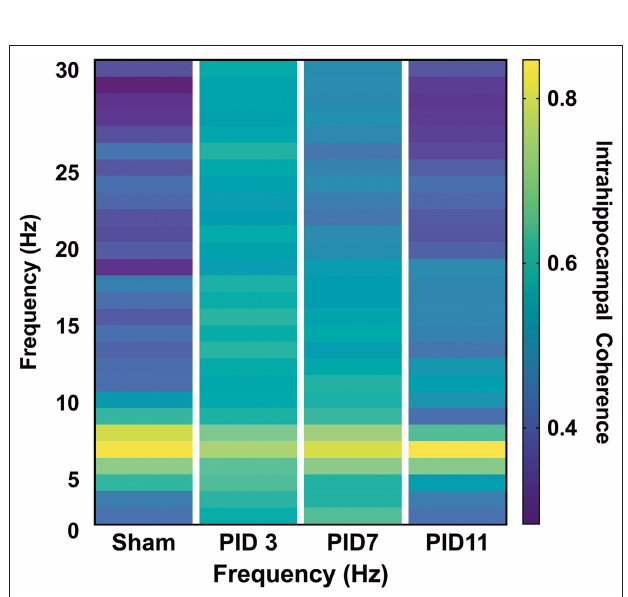
FIGURE 4 | Intrahippocampal Phase Coherence. (A) In sham animals, high phase coherence was observed between two neighboring hippocampal electrodes specifically in the theta-frequency range. (B) While there was not a significant decrease in theta phase coherence 3 days post-injury ( p = 0.056), there was a significant increase in coherence in the beta band ( p < 0.001). (C) At 7 days post-injury beta frequency coherence remained elevated ( p < 0.01) but (D) had returned to sham levels by post-injury day 11. Dashed lines highlight the theta band (6–10Hz). Adapted from Paxinos et al. (51).